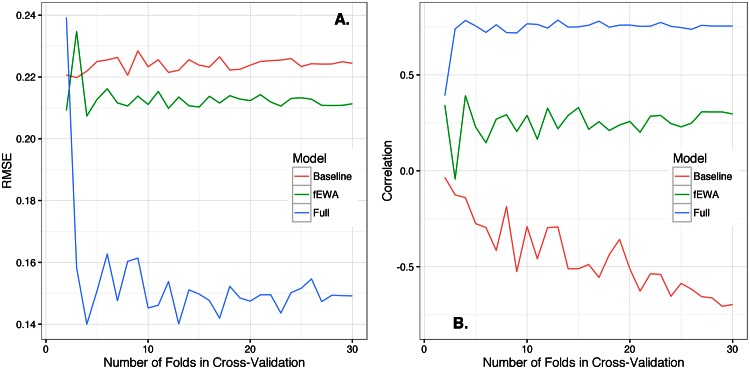
How predictive performance varies with data splitting.RMSE (A.) and correlation (B.) for time series forecasts of play in 30 game structures, varying folds in cross-validation from 30 to 2. The full model consistently has lower prediction error and higher correlation than the baseline model and the fEWA model until there are only two folds. It is, in general, difficult to make accurate predictions when the ratio of observational units to folds is small. In the case of predicting aggregate and dynamic play, the game structure itself is the observational unit, and we only have thirty, so it’s not surprising that performance can degrade at two folds depending on the particular random realization of fold assignments.